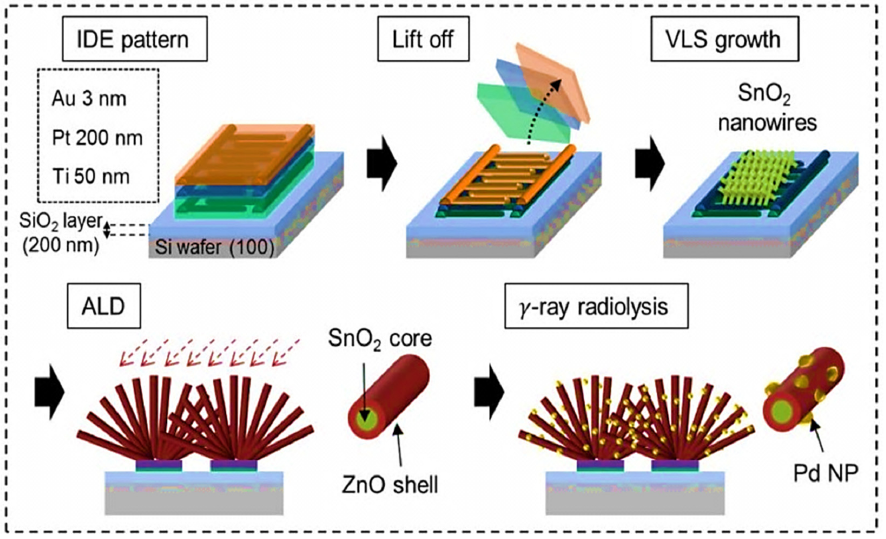
Figure 15. Schematic of the synthesis of Pd-decorated SnO 2 -ZnO C-S NWs. Reproduced from [104] with the permission of Elsevier.